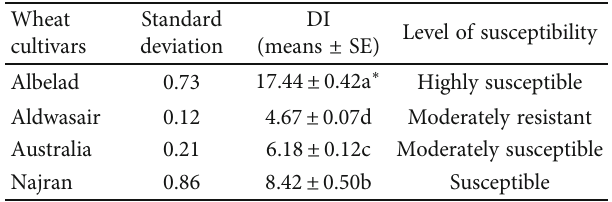
Table 4: Dobie ’ s index of susceptibility (DI) of four wheat cultivars.